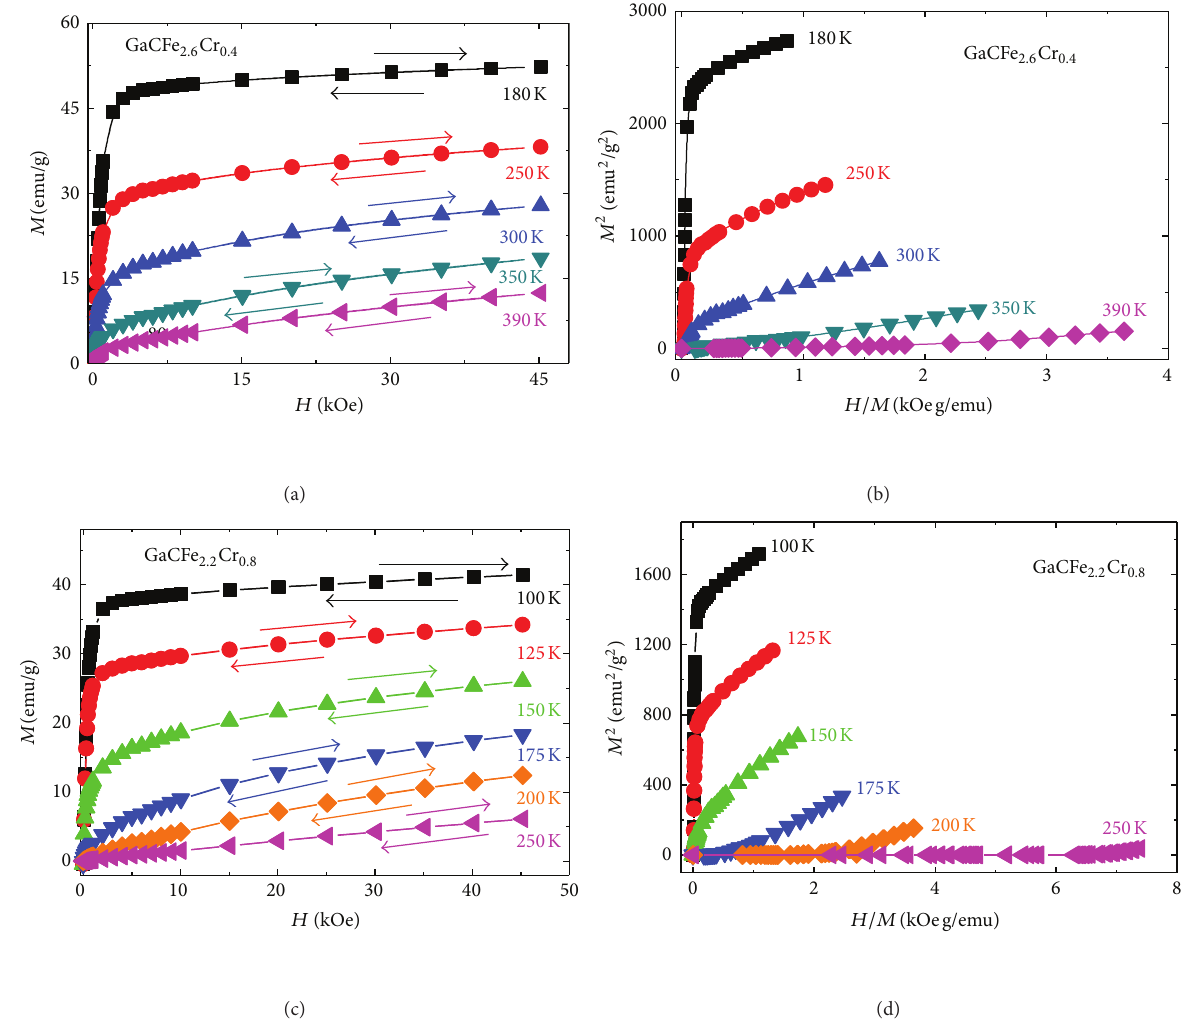
F 3: (Color online) (a) Isotherm magnetization